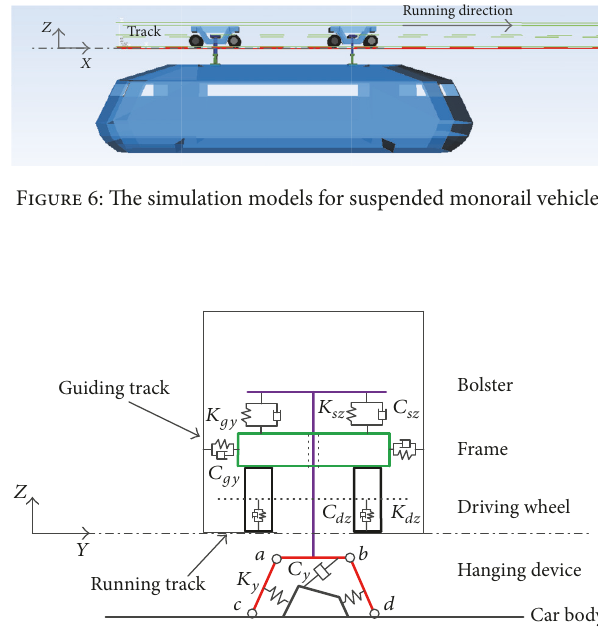
Figure 7: The simulation models of